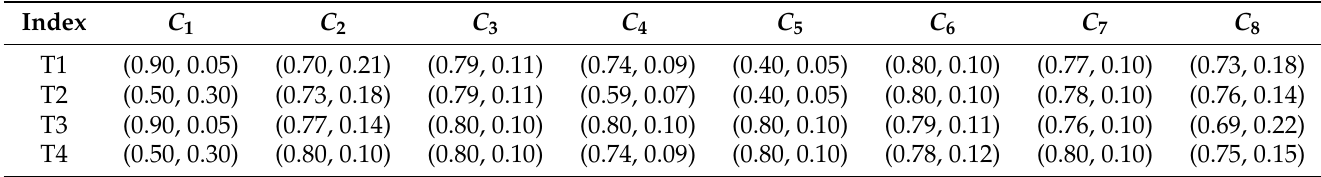
Table 3. IFS matrix of the air target